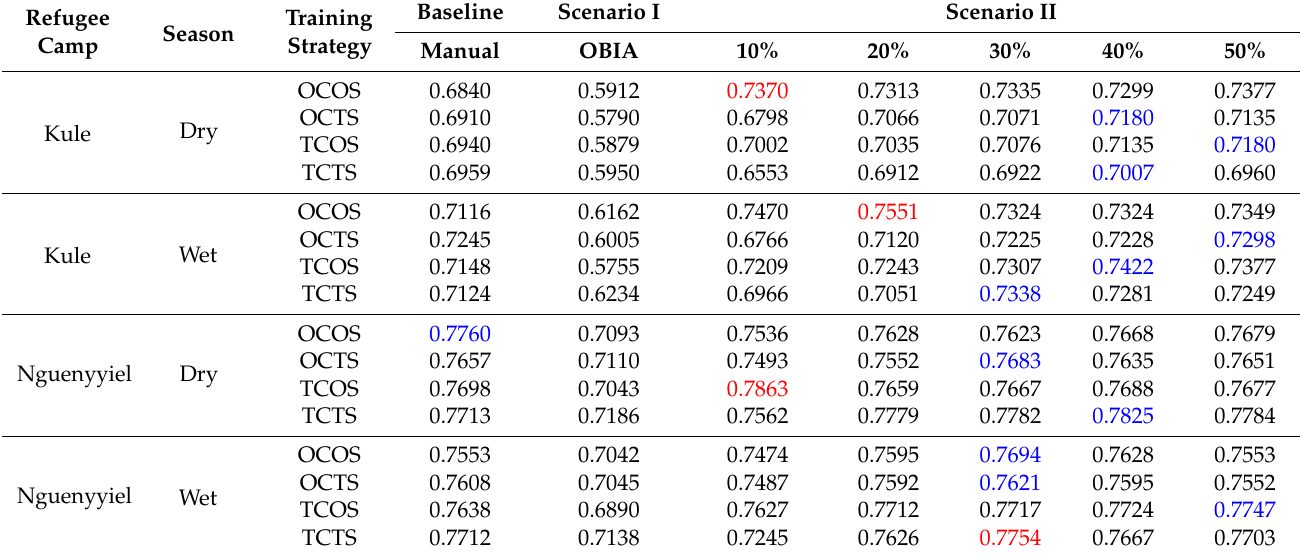
Table 3. The Recall values of built-up structures of all implemented experiments.